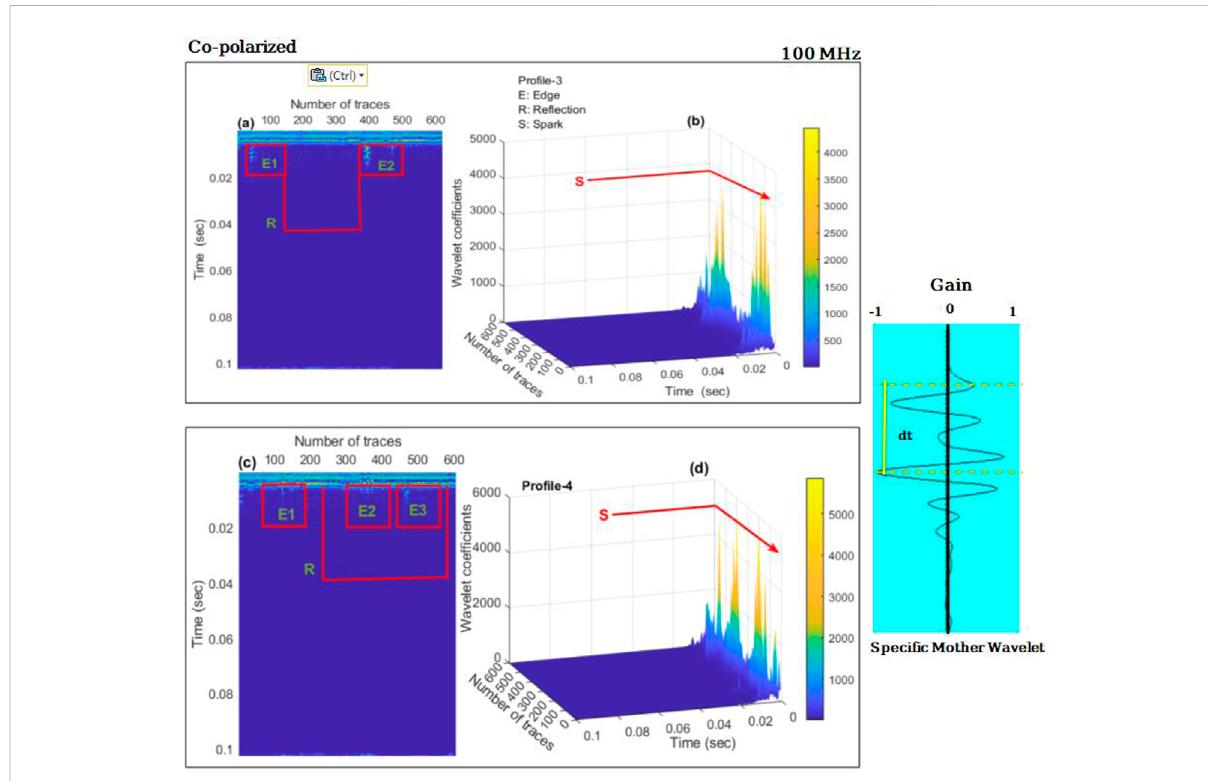
FIGURE 6 Continuous wavelet transformation (CWT) representation using co-polarized GPR data acquired at 100 MHz frequency, where (A) 2-D display of post-applied CWT E1 and E2 are the representation of the archeological edges, while rectangular R is the re fl ection event that appeared due to anomaly detection; and (B) post-application of Wavelet transform to the 3-D GPR data S de fi nes the spark at the time mode, and these sparks are associatedwiththeburiedsubsurfaceobjects. (C)